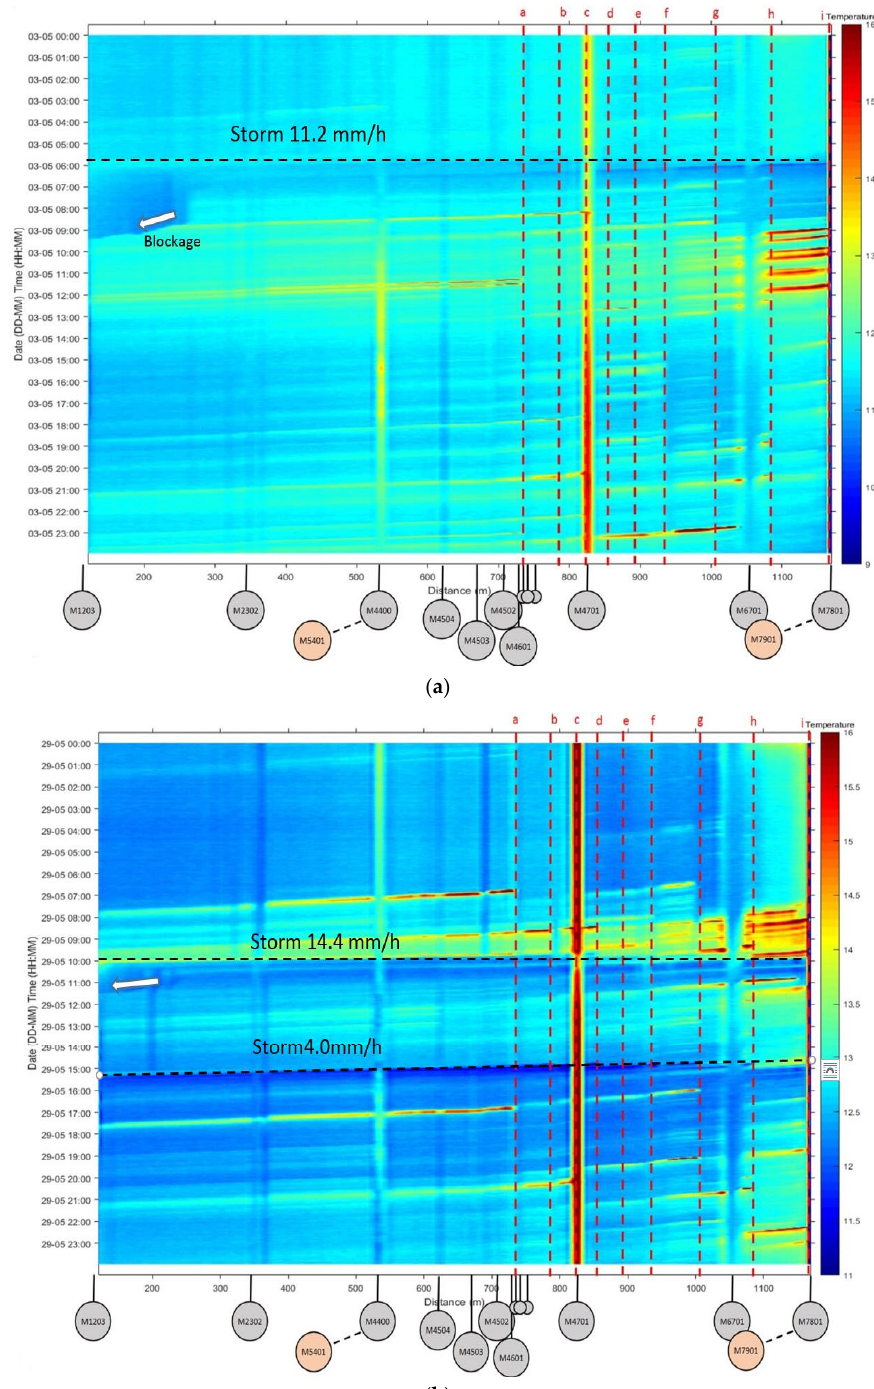
Figure 5. DTS monitoring results with moderate rain: ( a ) 3 May; ( b ) 29 May.